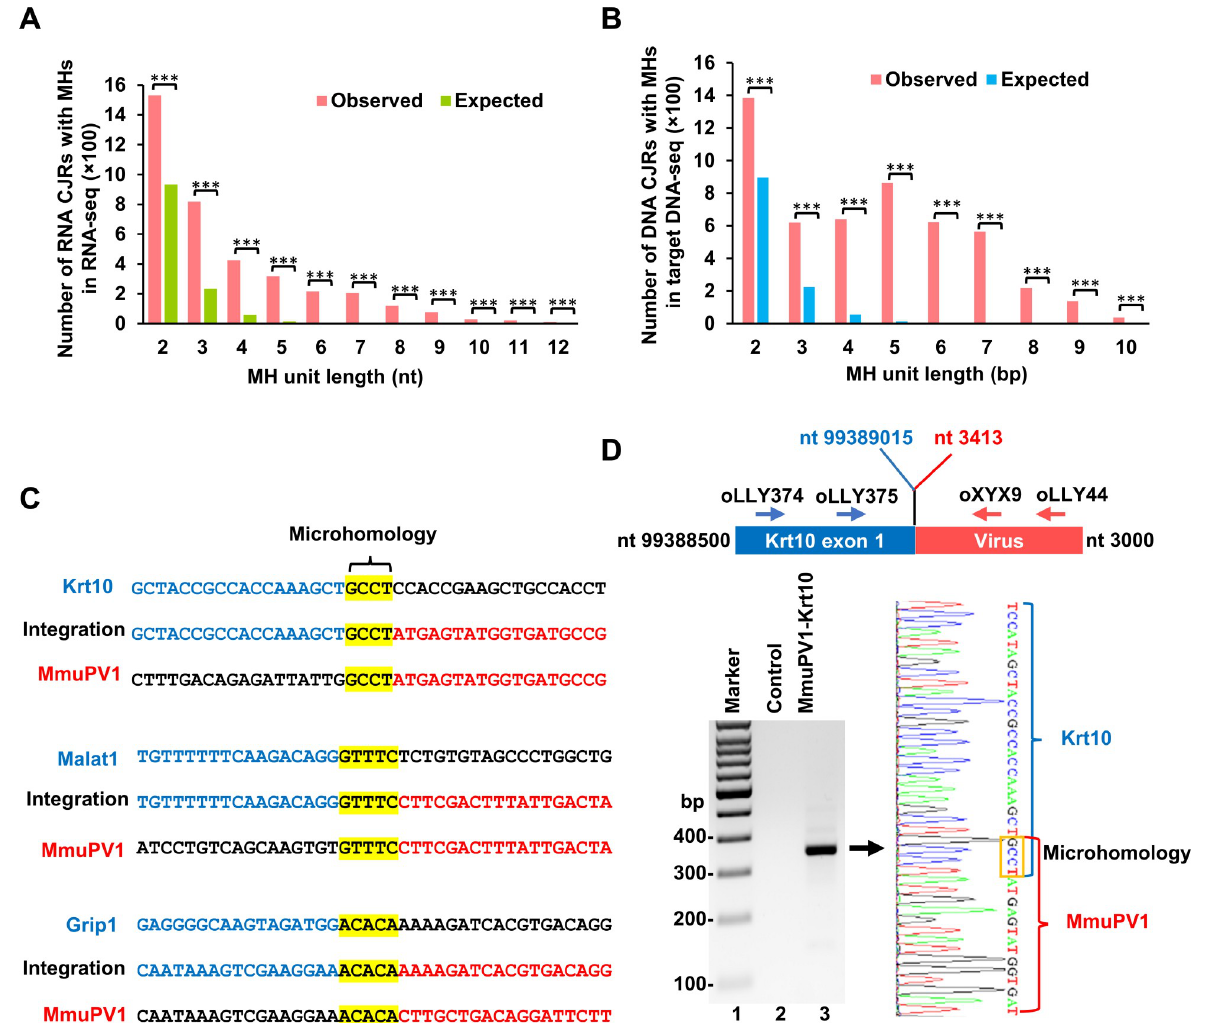
Fig 7. Identification of microhomology sequences in the MmuPV1 integration junctions. A and B, Microhomology sequences (MHS) are enriched in the junction regions of CJRs identified by RNA-seq ( A ) and targeted DNA-seq ( B ) when compared to the expected MHS at the hypothetic junction region of CJRs. ��� , P < 0.001 in chi-squared test. C , MHS identified at the MmuPV1-host integration junctions in Krt10, Malat1 and Grip1 by RNA-seq. Yellow color shows the MHS at the integration junction between MmuPV1 (NC_014326) and mouse (mm10) reference genomes. Blue and red colors indicate the upstream and downstream host and viral sequences at the integration site junction. D, Verification of MHS in a MmuPV1-Krt10 integration site from muzzle tumor tissues of animal #2 ( Fig 2B for sample #6 ) by RT-PCR and sequencing. A pair of primers oLLY374 (located on Krt10) and oLLY44 (located on MmuPV1 E2 region) were used for the first round PCR and the primer pair of oLLY375 (located on Krt10) and oXYX9 (located on MmuPV1 E2 region) were used for nested PCR (top diagram). A primer pair, oMA1 from the Gapdh gene and oLLY44 from MmuPV1, was used as a negative control. See details in S10 Table for all primer sequences and locations. The MHS (GCCT) in the amplicons (gel panel, lane 3) was confirmed by Sanger sequencing (right) and highlighted in a yellow